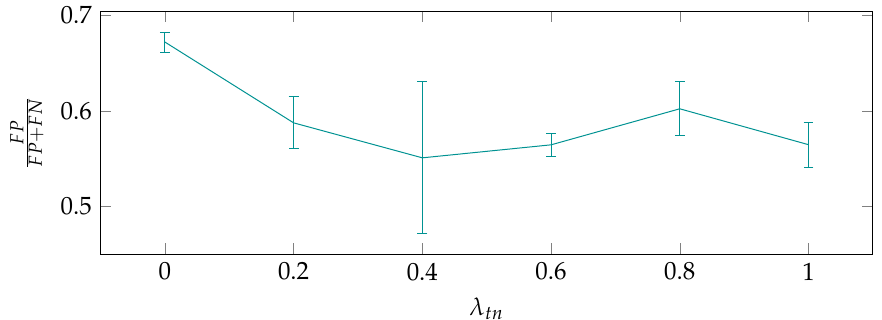
Figure 9. The portion of false predictions that are false positives, plotted against the true negative weight λ tn . The score for each value of λ tn is the average of two models trained with that value. The error bars show the minimum and maximum values of the two models.